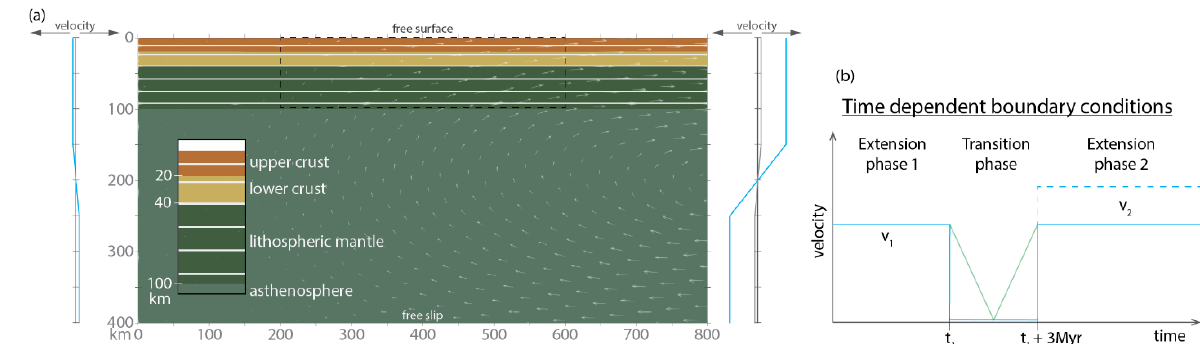
Figure 2. ( a ) Initial model setup. Colours show the compositional fields, arrows show the velocity field, isotherms are plotted every 200 ° C, and the dashed rectangle outlines the area where an initial random cohesion and friction field is imposed. Velocities profiles on the right and left sides show the imposed velocity boundary conditions of the side boundaries. ( b ) Variations of velocity boundary conditions during the models’ evolution; a first phase of extension with imposed velocity v 1 on the right boundary until time t 1 is followed by a transition phase of 3 Myr with no extension or a linear deceleration and acceleration (green line), which is then followed by a second phase of extension with velocity v 2